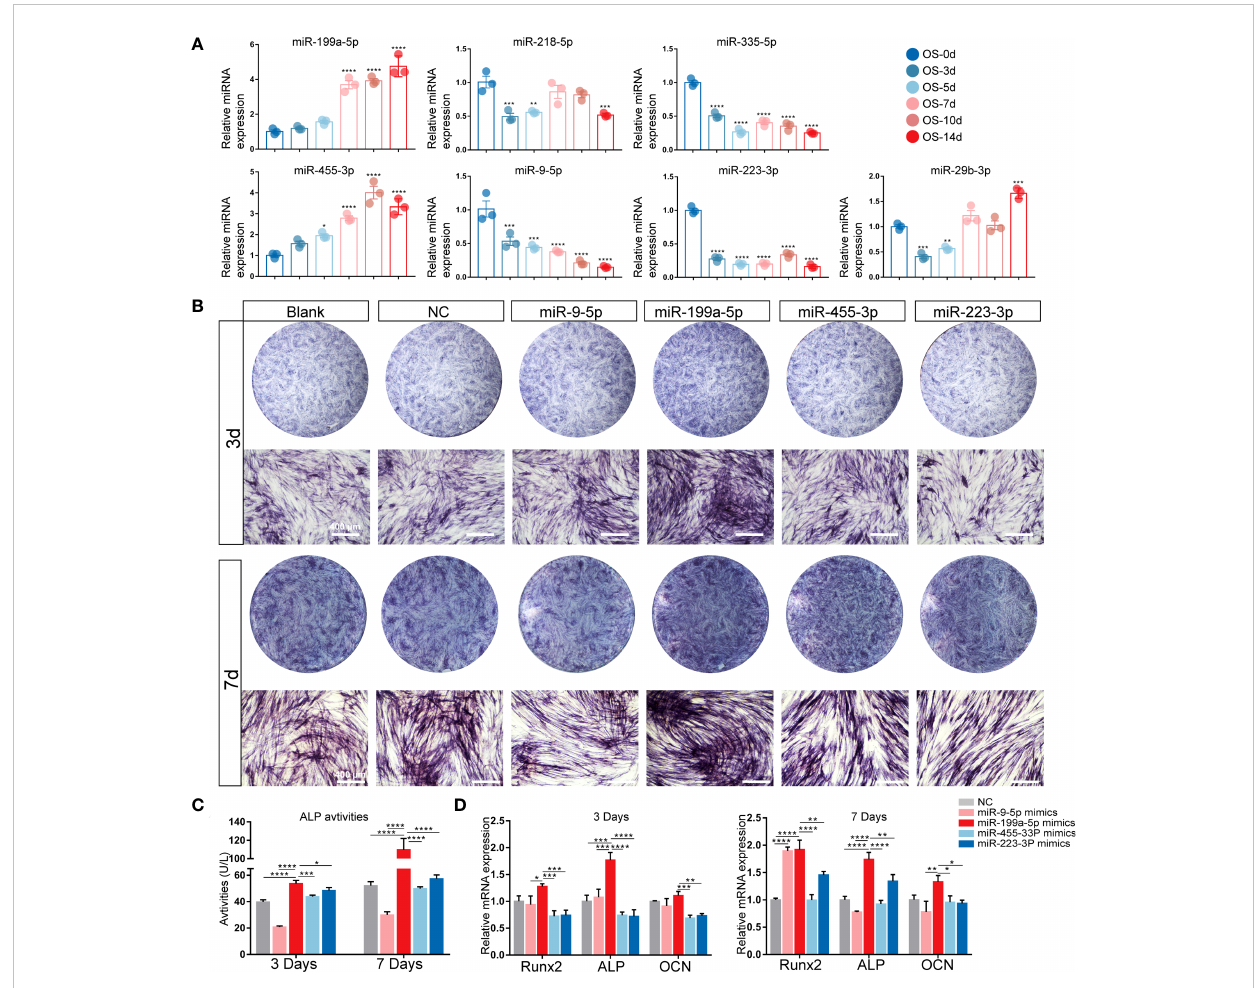
FIGURE 2 Expression patterns of the candidate miRNAs during osteogenic differentiation of hSCAPs. (A) Relative expression of the 7 screened miRNAs. (B) ALP staining of different miRNA overexpression groups after 3 and 7 days of osteogenic induction (scale bar = 400 m m). (C) ALP activity in the different groups. (D) The relative mRNA expression level of osteogenic marker genes RUNX2, ALP, and OCN. The data were shown as mean ± SD. * p < 0.05, ** p < 0.01, *** p < 0.001, and **** p <